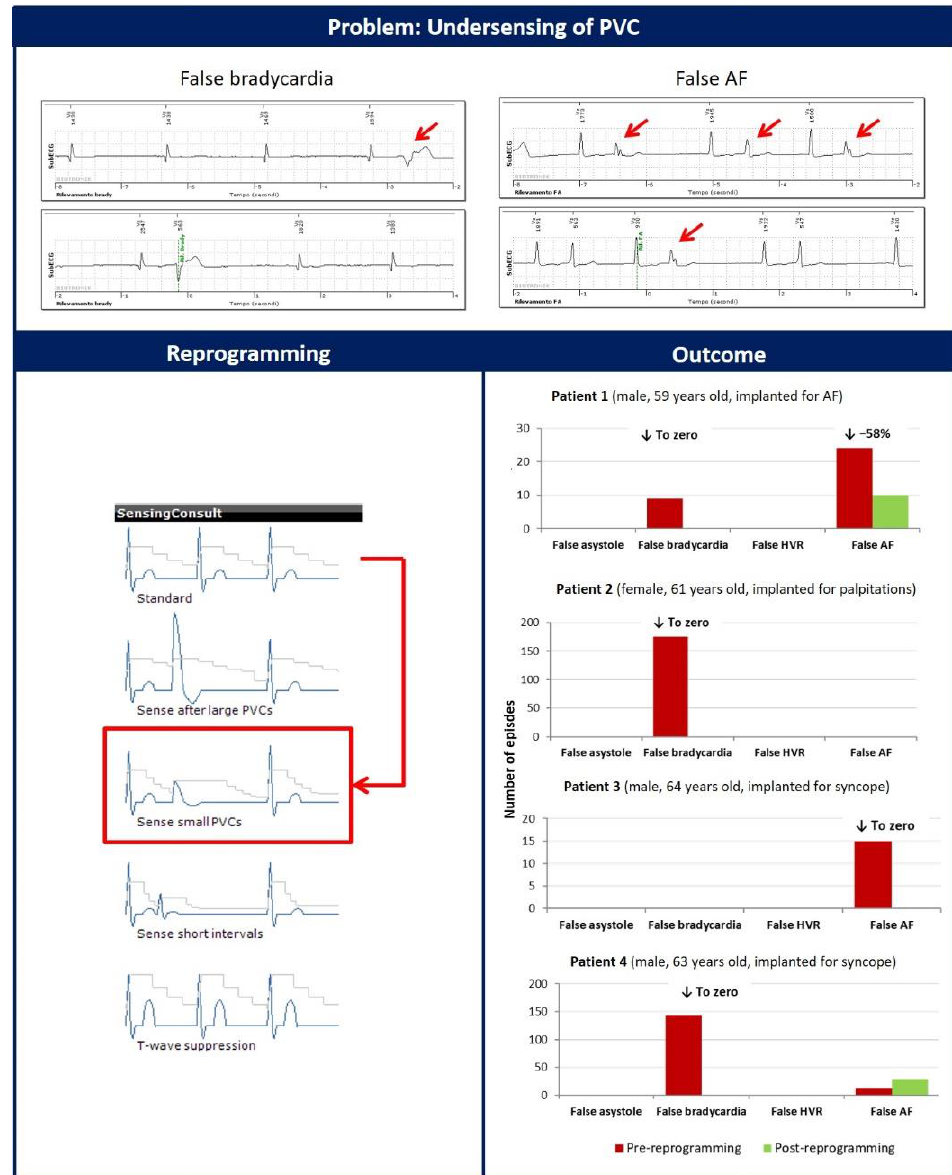
Figure 1. Red arrows indicate the undersensing of large, but low-amplitude premature ventricular contractions (PVCs). The reprogramming of the parameter ‘ Sensing Consult ’ from ‘ Standard ’ to ‘ Sense small PVC ’ significantly decreased the number of false bradycardia and atrial fibrillation episodes.